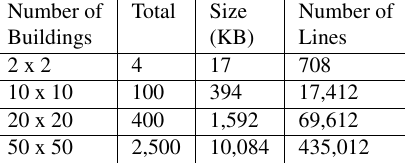
Table 1: CityGML Size (in KB) and number of lines